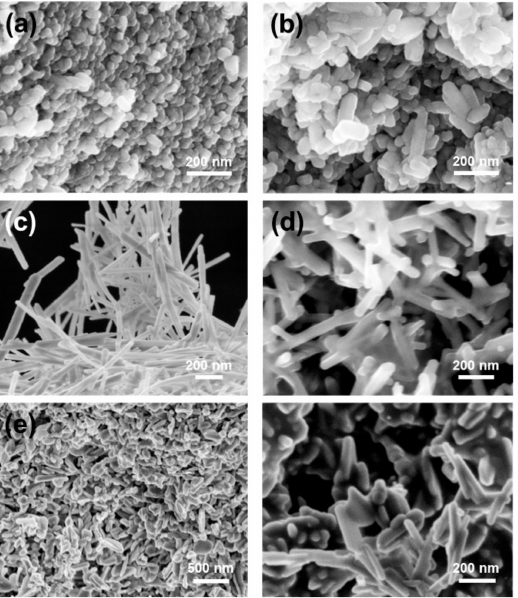
Figure 4. Different morphologies of HAP obtained from the methods proposed by Sans et al. [75]: ( a ) spherical polymorphs; ( b ) rod shapes; ( c ) belts; ( d ) belts with smaller aspect ratio; ( e ) low magnification of needle-flakes; and high magnification of needle-flakes. With permission from ACS Publications. https://doi.org/10.1021/acs.cgd.0c00850 (accessed on 5 April